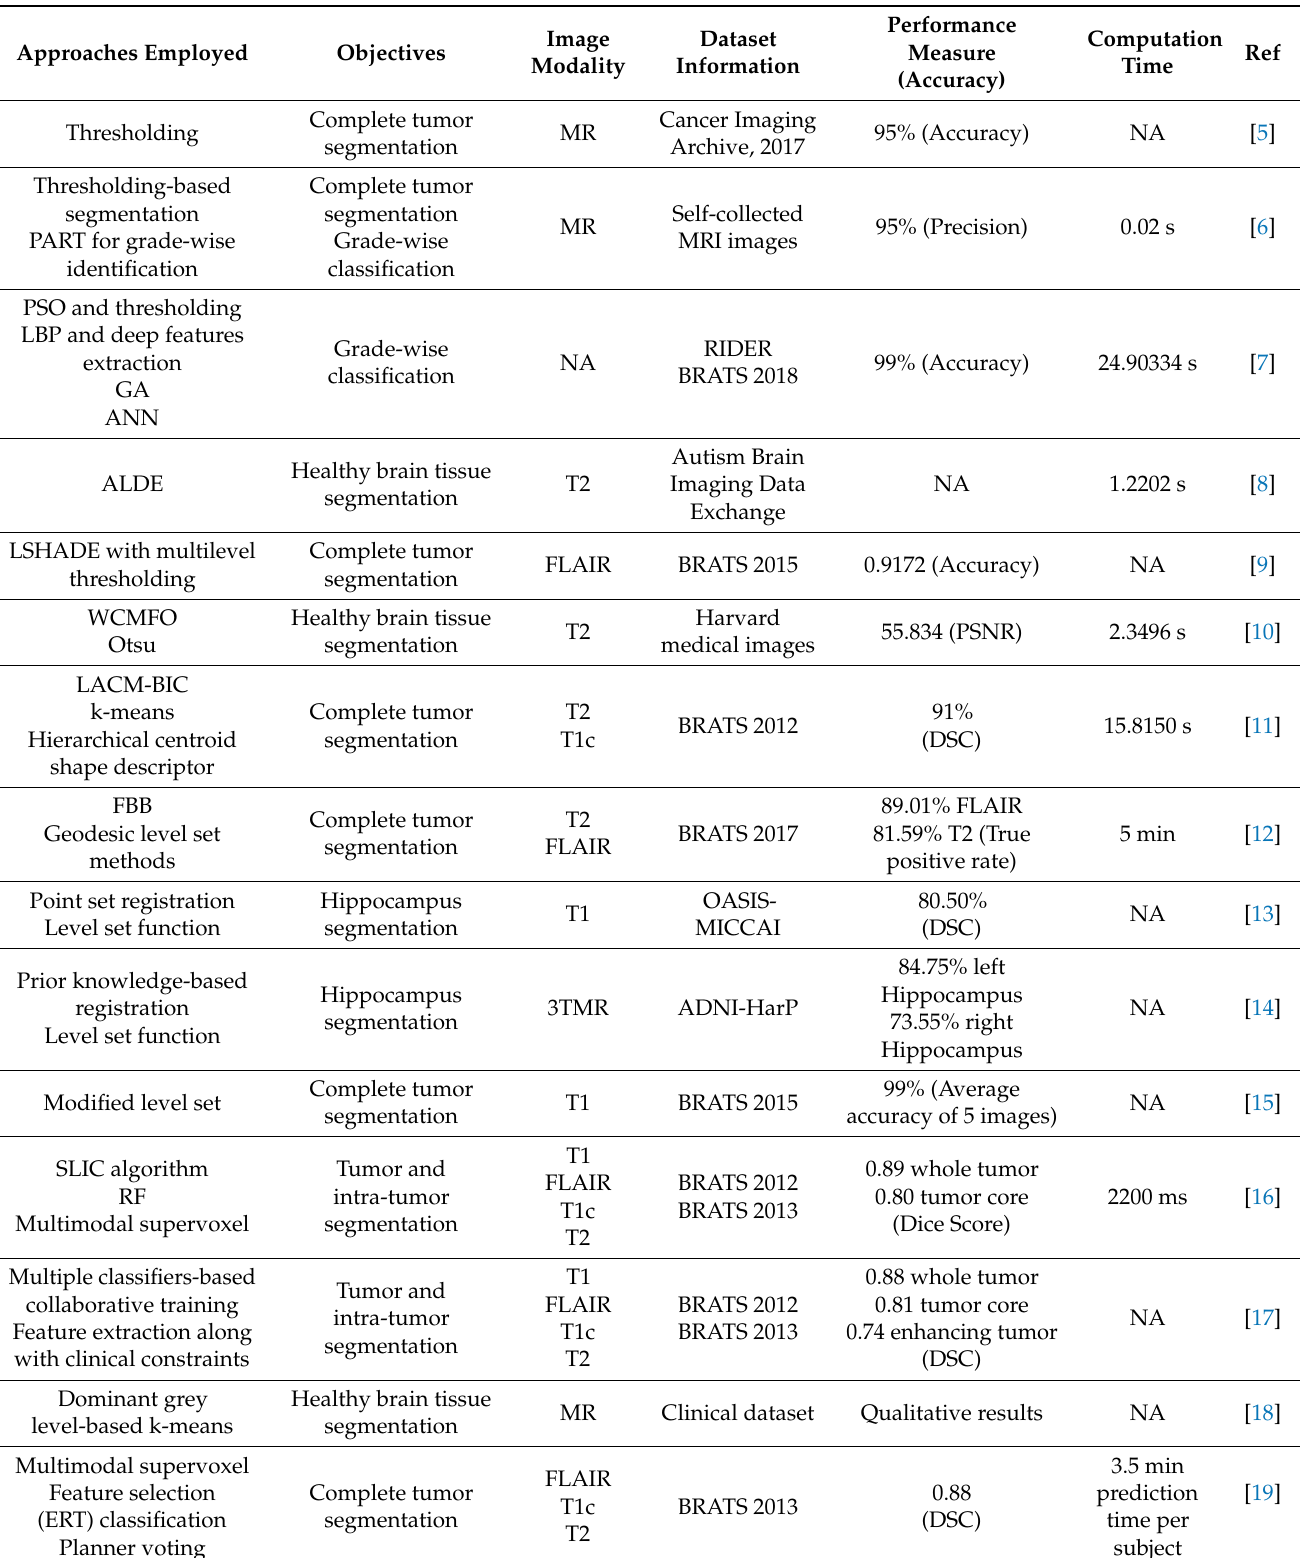
Table 3. Summary of brain segmentation approaches ( NA denotes Not Available